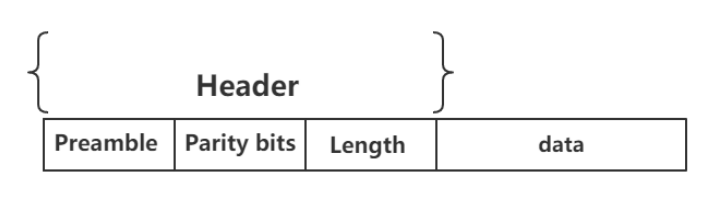
Figure 3. The format of audio wave